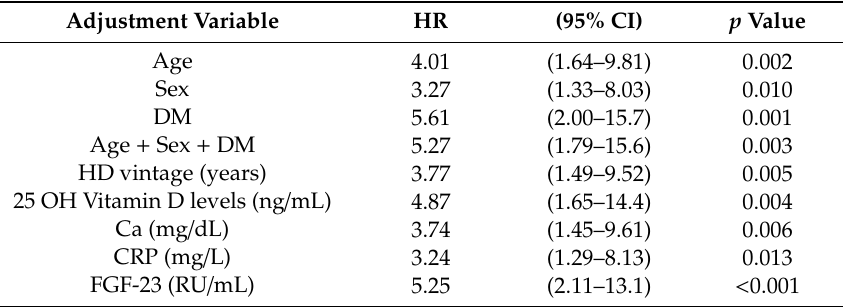
Table 5. Calcidiol and paricalcitol combination and